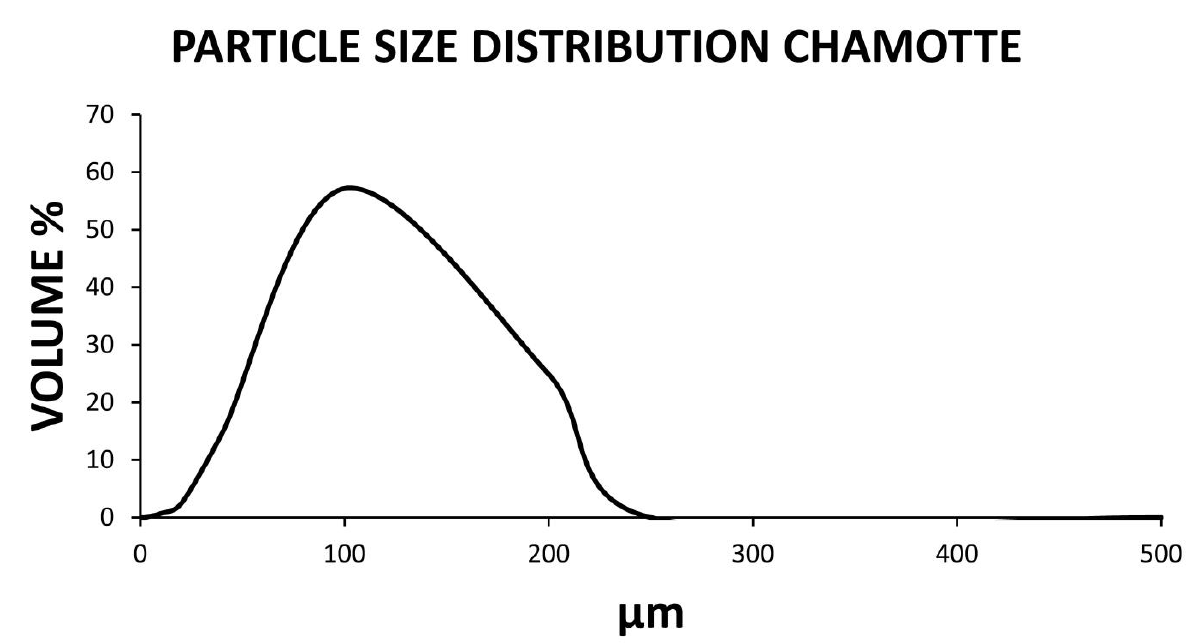
Figure 1. Graph of the laser granulometry of the sieved chamotte by a 0.25 mm sieve. Similarly, Figure 2 shows the particle size distribution of the bottom ash of the biomass sieved by a 0.25 mm sieve after mashing and drying. The distribution of the particles was observed from 10 to 200 um, as a finer material than the chamotte and suitable for use as an activator in geopolymers. It should be noted that different authors have studied and corroborated that the fineness of the materials used in the conformation of the geopolymer greatly influences the final mechanical characteristics.